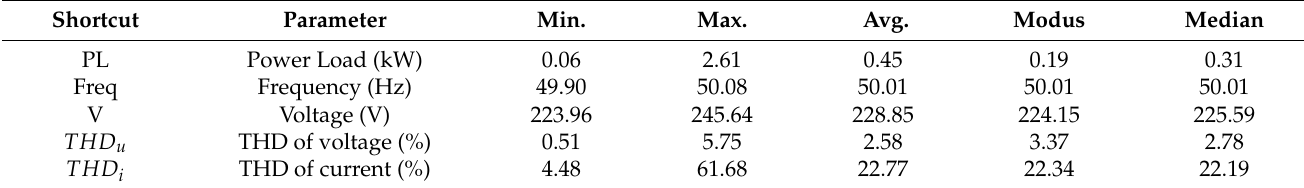
Table 5. PQPs dataset